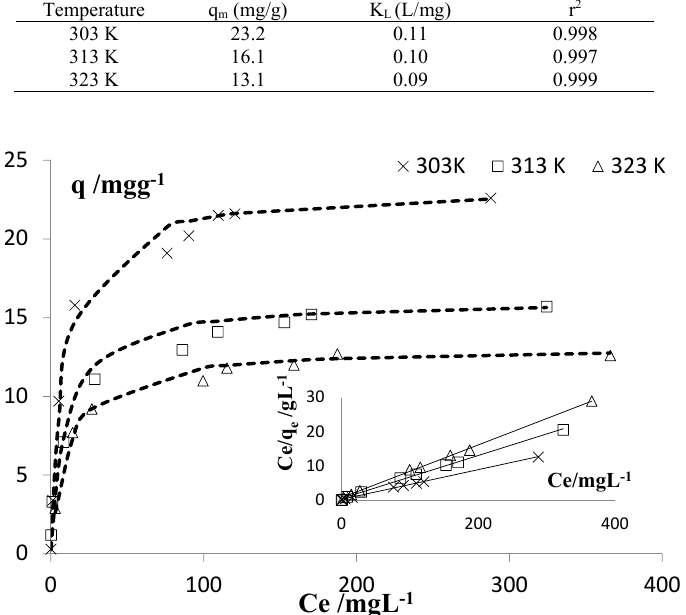
Fig. 2: Adsorption isotherms of MB onto sawdust at three different temperatures 303, 313 and 323 K. Comparison of experimental data (symbols) with Langmuir models (lines). Inset panel: Linear form of Langmuir isotherms. Operating conditions: msawdust=0.5g, V=50 mL, C°= 12-600 mg/L.